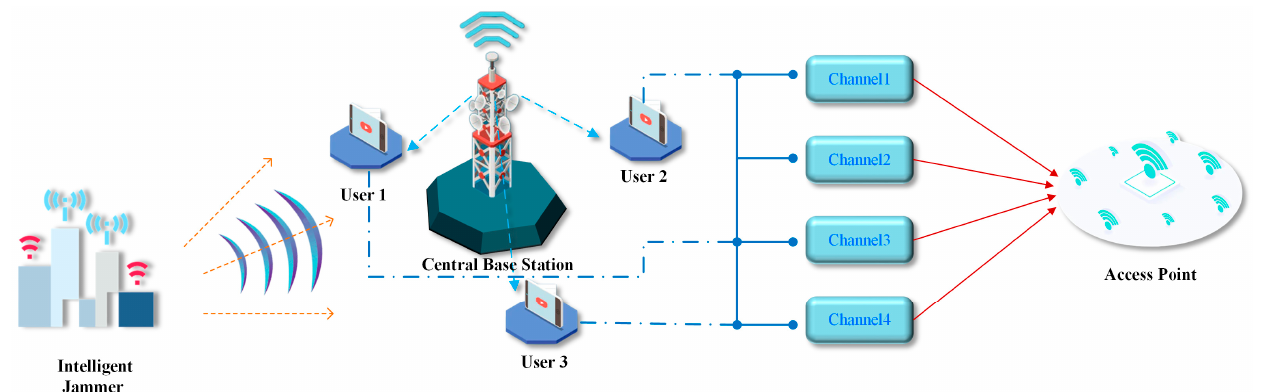
3, 4 N M = = as an example).